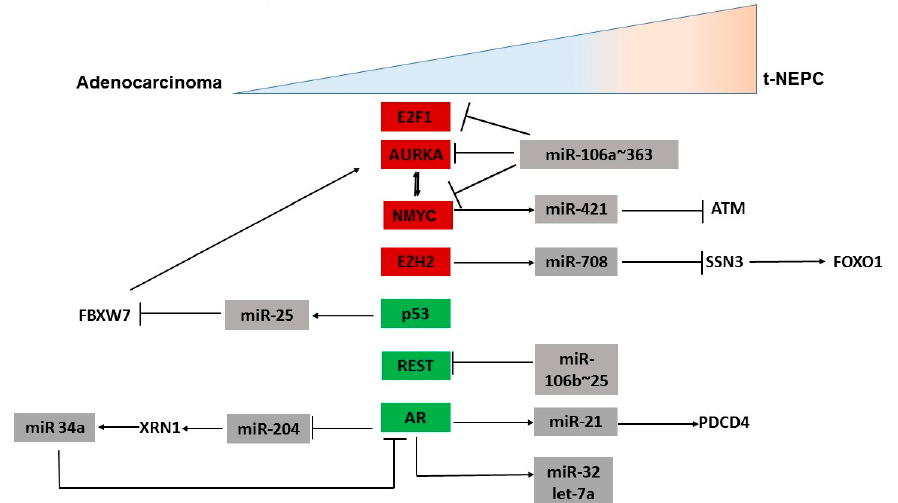
Figure 1. MicroRNAs impact key genes implicated in neuronal differentiation of prostate cancer cells. Schematic representation of miRNA–mRNA interactions underlying neuroendocrine differentiation in prostate cancer cells. Upregulated key genes in NEPC are highlighted in red and downregulated key genes are highlighted in green.